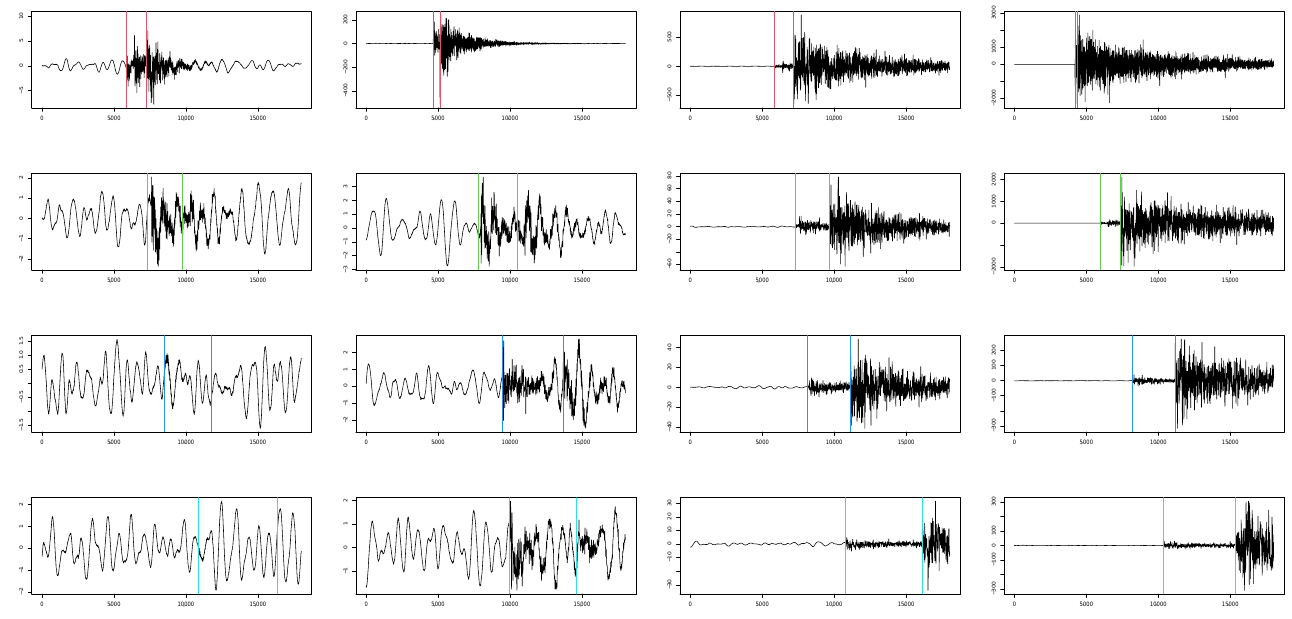
Figure 1. An example of the simulated waveforms for each of the discussed scenarios and the true arrival times in seconds multiplied by the sampling step in hertz. In the columns : magnitude levels from Table 1, increasing from left to right. In the rows : distance from the nearest seismic station from Table 1, increasing from top to